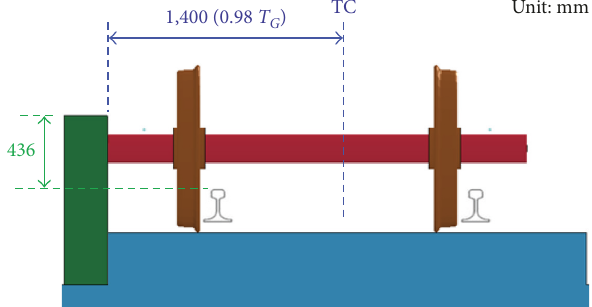
Figure 18: Overview of height effect